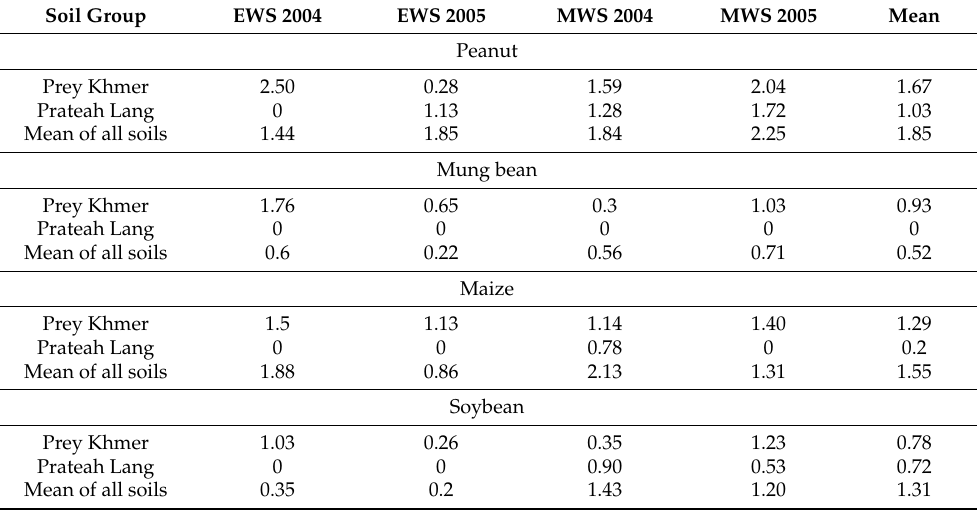
Table 9. Yields of crop species (t ha − 1 ) from on-farm trials on Prey Khmer and Prateah Lang Soil Groups in 2004 and 2005 in early wet season (EWS—May) and main wet season (MWS—mid-July– mid-August) planting